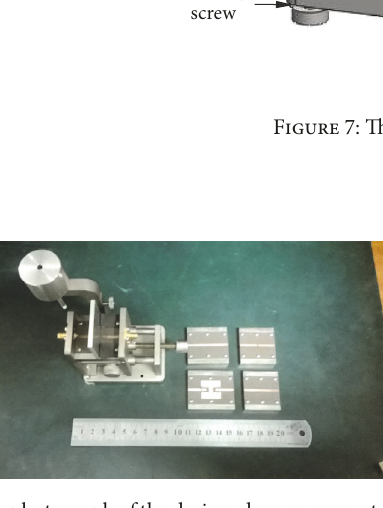
Figure 10: The photograph of the measurement